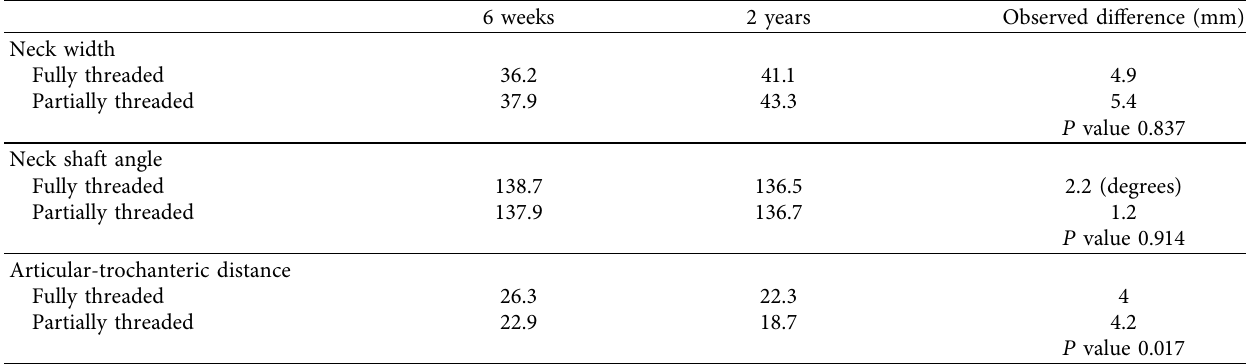
Table 4: Neck width, neck shaft angle, and articular-trochanteric